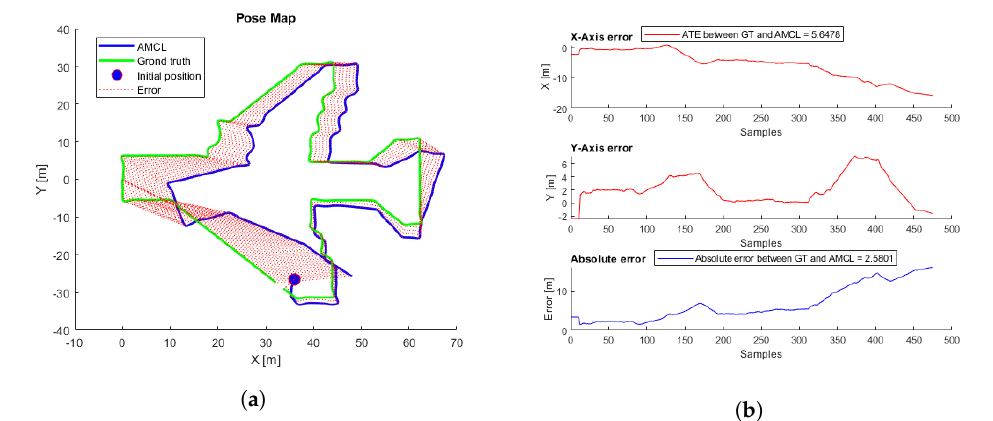
Figure 10. ( a ) AMCL simulation test with the highest ATE. AMCL (blue), ground-truth (green), take-off position (blue circle), error (red). ( b ) AMCL errors. Table 3. Initial positions for lowest and highest ATE trajectories.